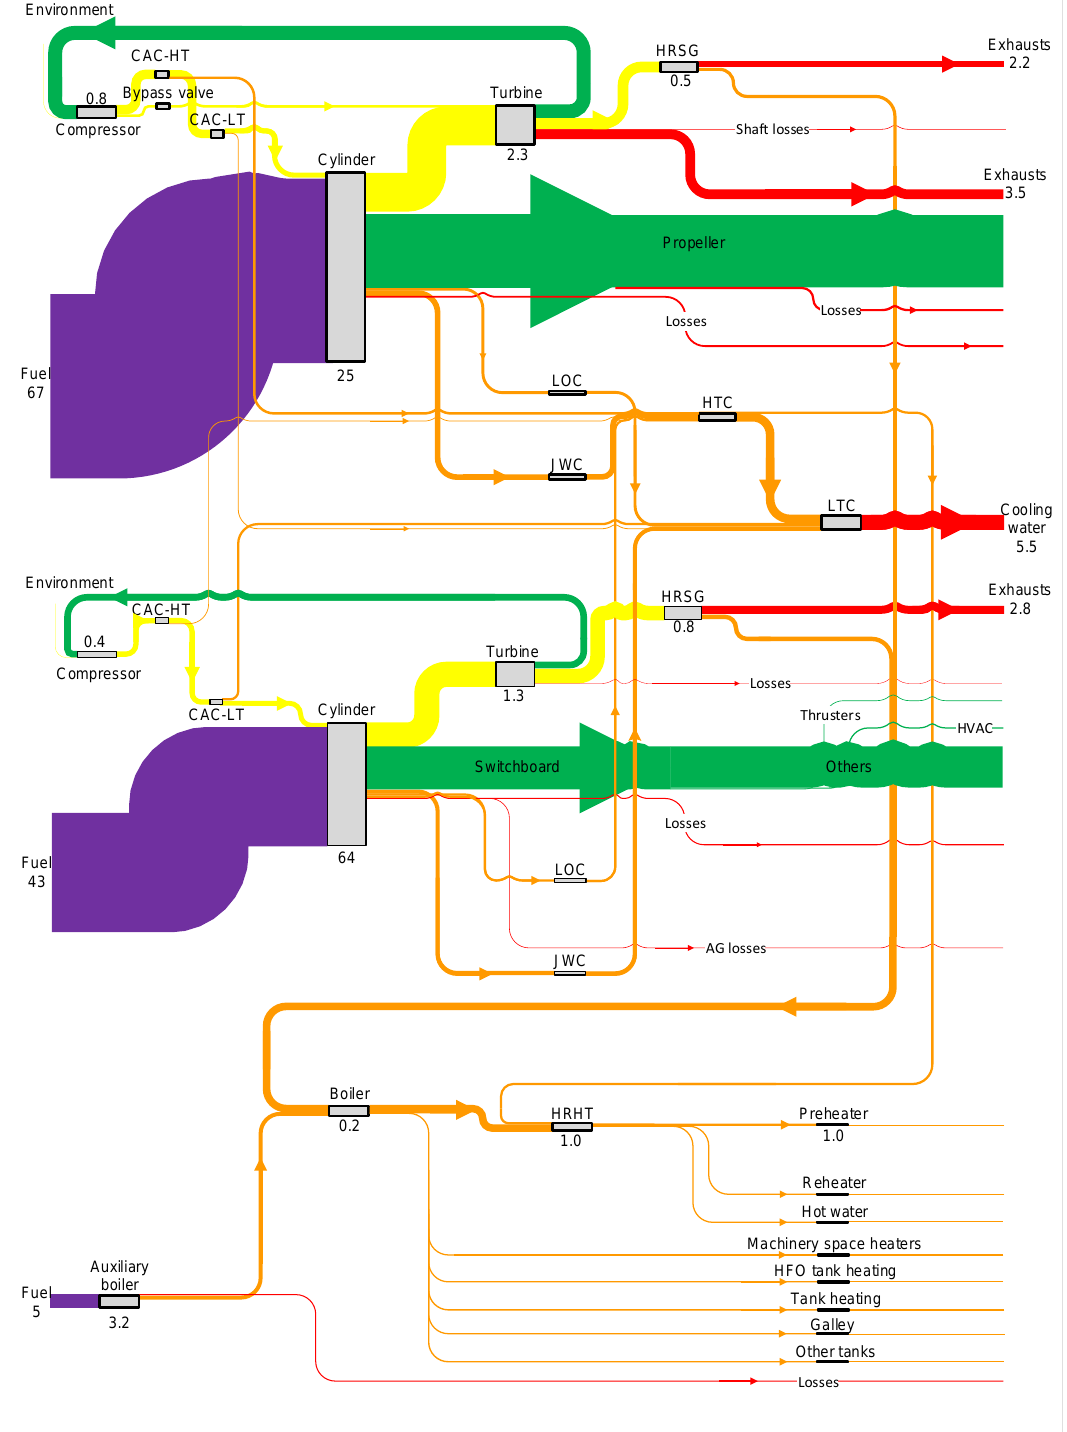
Figure 18. Grassmann diagram. The purple color refers to chemical exergy; the green color refers to electric/mechanical exergy. The yellow color refers to the exergy in the exhaust gas; the orange color refers to the exergy in the cooling flows; the red color refers to the energy losses. The exergy destruction is not represented to preserve the readability of the diagram. Flow values are in